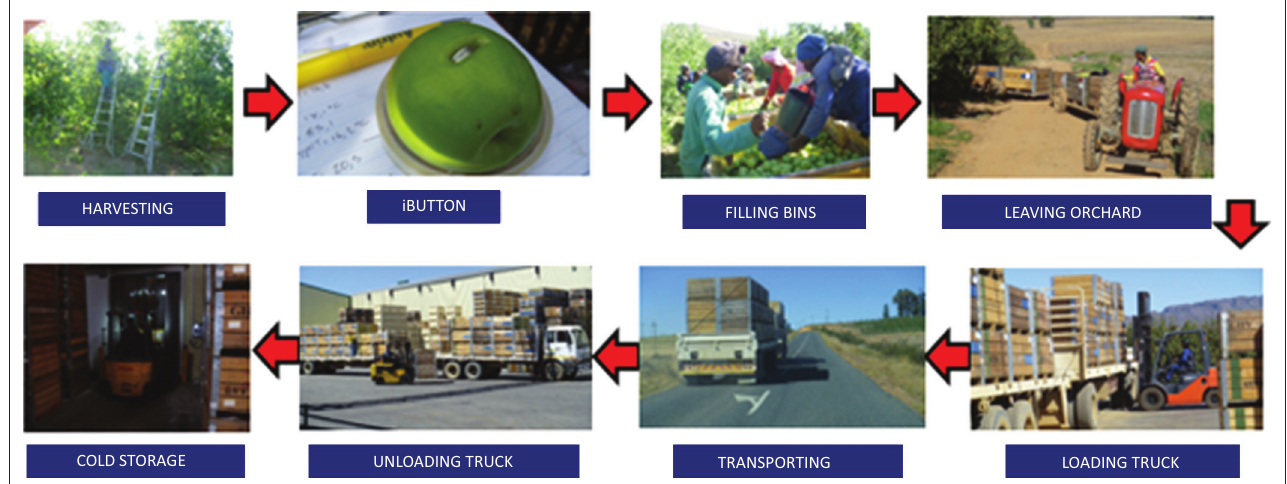
FIGURE 1: A flow diagram of the supply chain of an apple until 48 hours